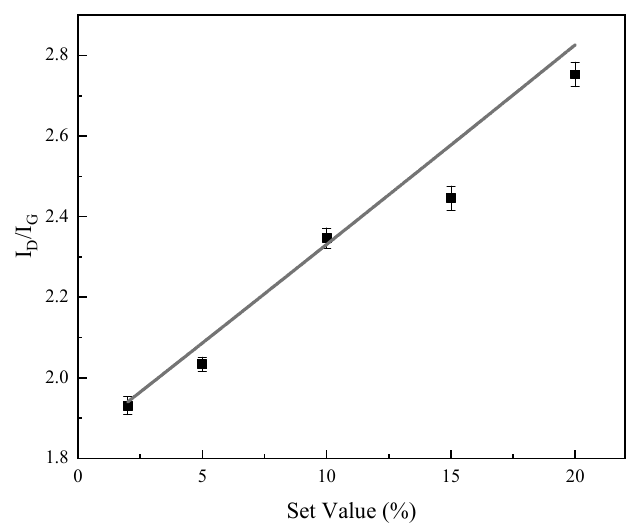
Figure 8. I D / I G ratios of Cr-DLC films deposited at different set values.